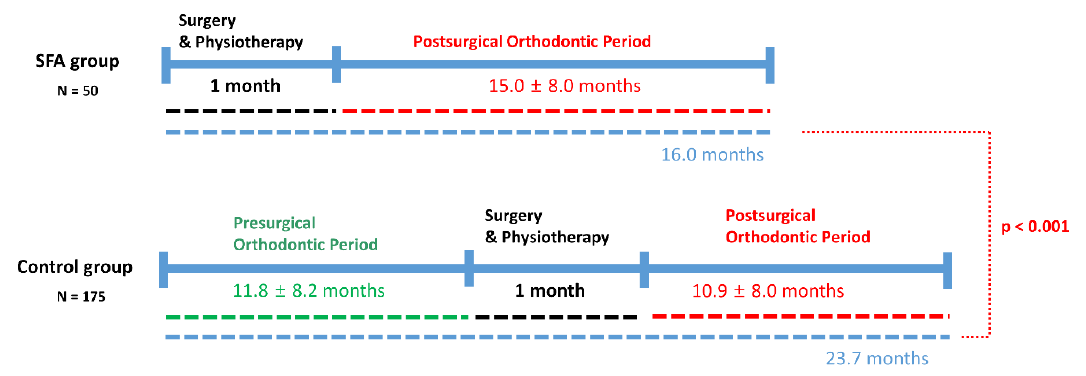
Figure 5. Comparison of total treatment time between the surgery-first approach (SFA) group and control group.